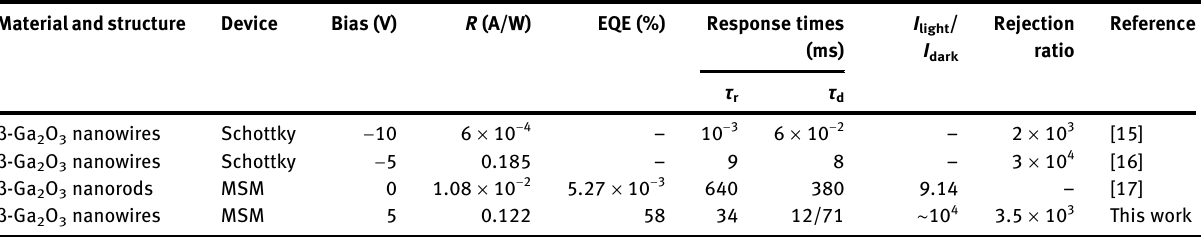
Table  : Comparison of critical parameters for the state-of-the-art solar-blind PDs based on β -Ga  O  nanowire arrays. Materialandstructure